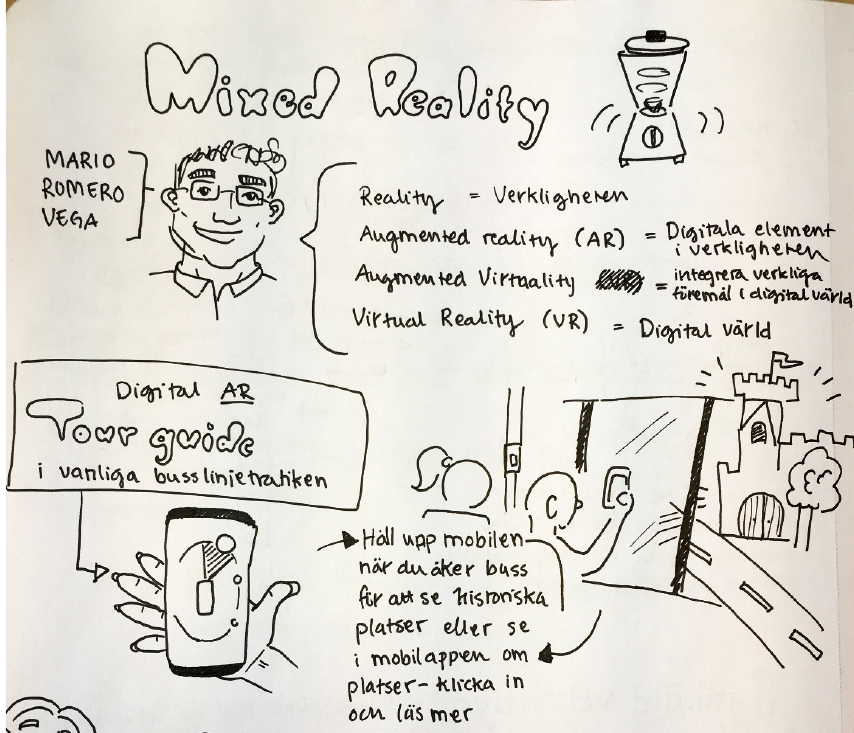
Figure 4. Mixed reality (graphic recorder Johanna Balogh). That is profitable for both parties, also bringing the university closer to the city